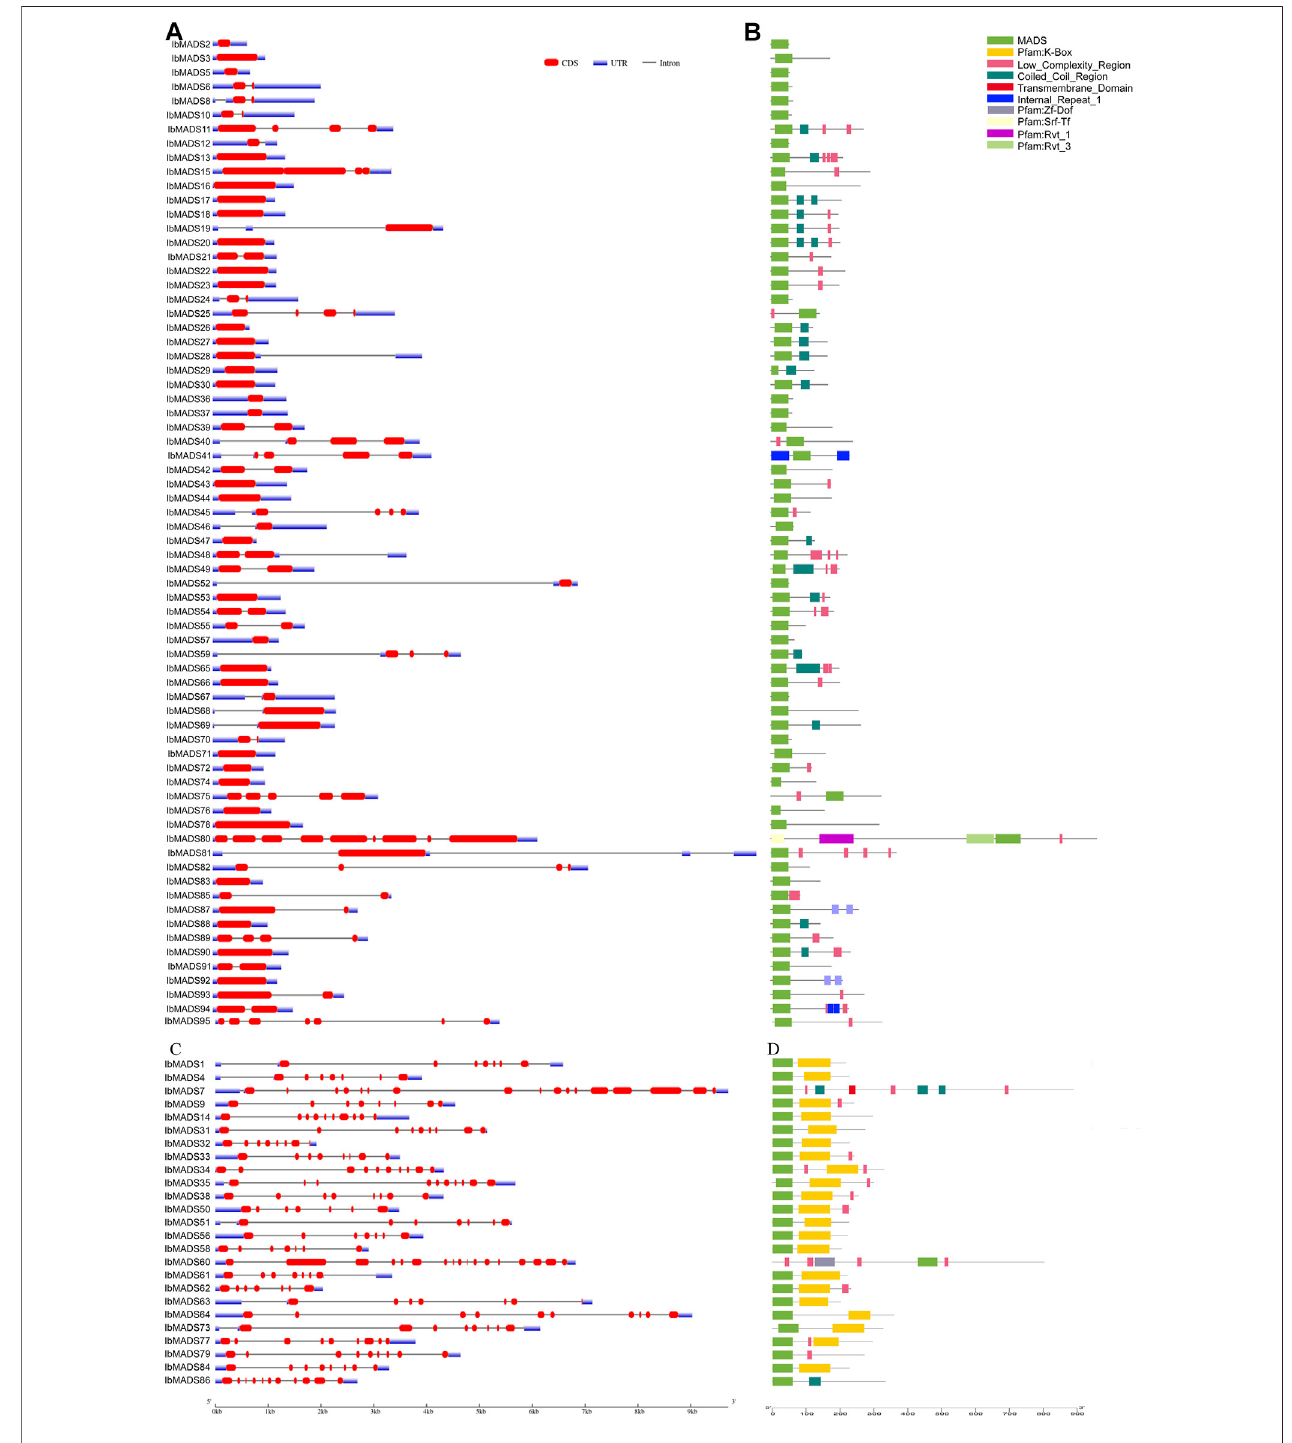
calculated by the 2 − ΔΔ Ct method (Livak and Schmitten, 2001). Data processing and analysis were performed using SPSS software, and column graphs were drawn using origin 8.5.